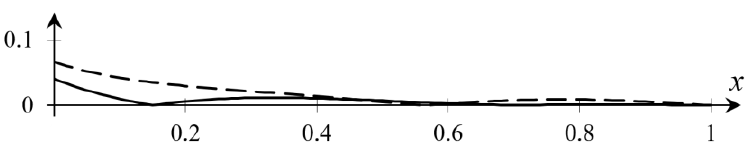
Figure 9. Graphs of the functions 𝜀 1 (𝑥, 3) (solid line) and 𝜀 2 (𝑥, 3) (dashed line).